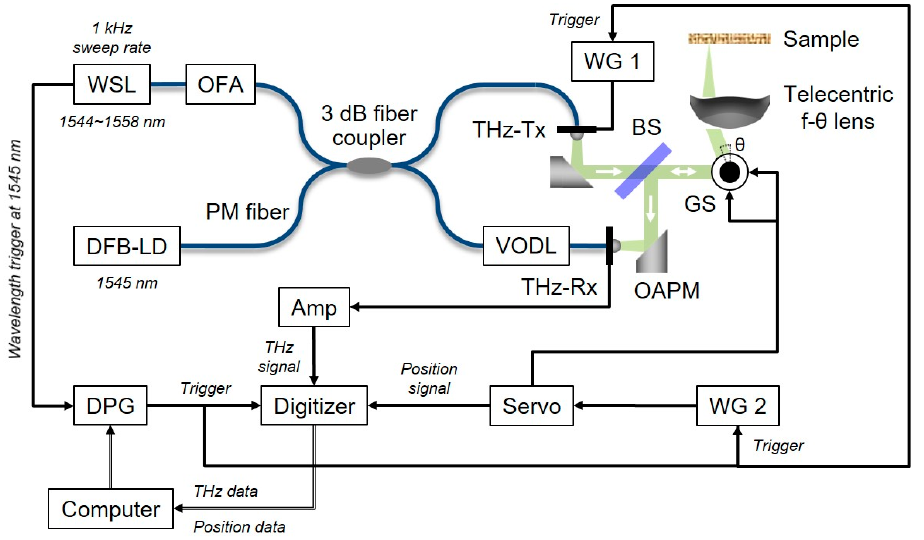
Figure 2. Schematic diagram of our frequency-domain THz tomography system. WSL: wavelength- swept laser, OFA: polarization-maintaining optical fiber amplifier, DFB-LD: distributed feedback laser diode, PM fiber: polarization-maintaining fiber, THz-Tx: THz CW transmitter, WG: waveform generator, VODL: variable optical delay line, THz-Rx: THz CW receiver, OAPM: off-axis parabolic mirror, BS: silicon beam splitter, GS: 2D galvanometer scanner, DPG: digital delay/pulse generator, Amp: current preamplifier.